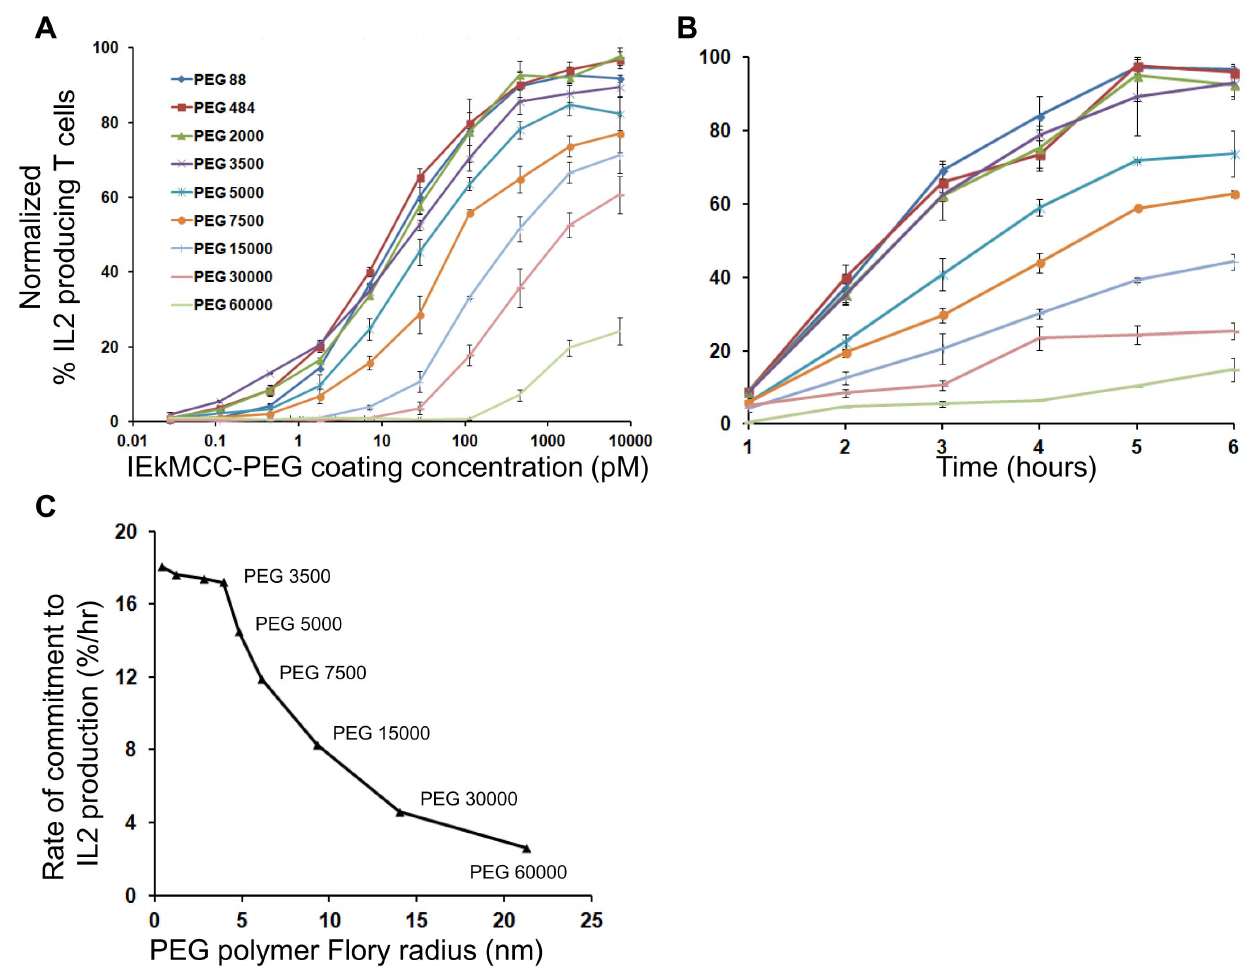
Figure 4. T cell activation by IEkMCC tethered with PEG polymers of different lengths. (A) T cell IL2 production in response to IEkMCC-PEG ligands of varying coating densities after 6 hours of stimulation. Data are representative of three independent experiments. The percent of T cells producing IL2 was determined by intracellular staining and flow cytometry. Three experiments using T cells from three different mice were performed (see Fig. S8 for flow cytometry plots). The percent of T cells producing IL2 was normalized to the highest value in each experiment. The data points are averages of the normalized values with standard errors of the means. (B) The rate of T cell response to IEkMCC ligands tethered with PEG polymers of different lengths. T cell IL2 production in response to stimulation on 96 well plates coated with 110 pM IEkMC-PEG ligands. T cells were harvested every hour for 6 hours and levels of IL2 expression were assayed by flow cytometry. Three experiments using T cells from three different mice were performed (see Fig. S9 for flow cytometry plots). The percent of T cells producing IL2 was normalized to the highest value in each experiment. The data points are averages of the normalized values with standard errors of the means. (C) The rates of T cell IL2 responses to IEkMCC ligands tethered with PEG polymers were extracted from the slope of linear fitting curves in Fig. 4B and plotted against the Flory radius of the polymers. The linear regressions and equations for deriving the rates are shown in Fig. S7.